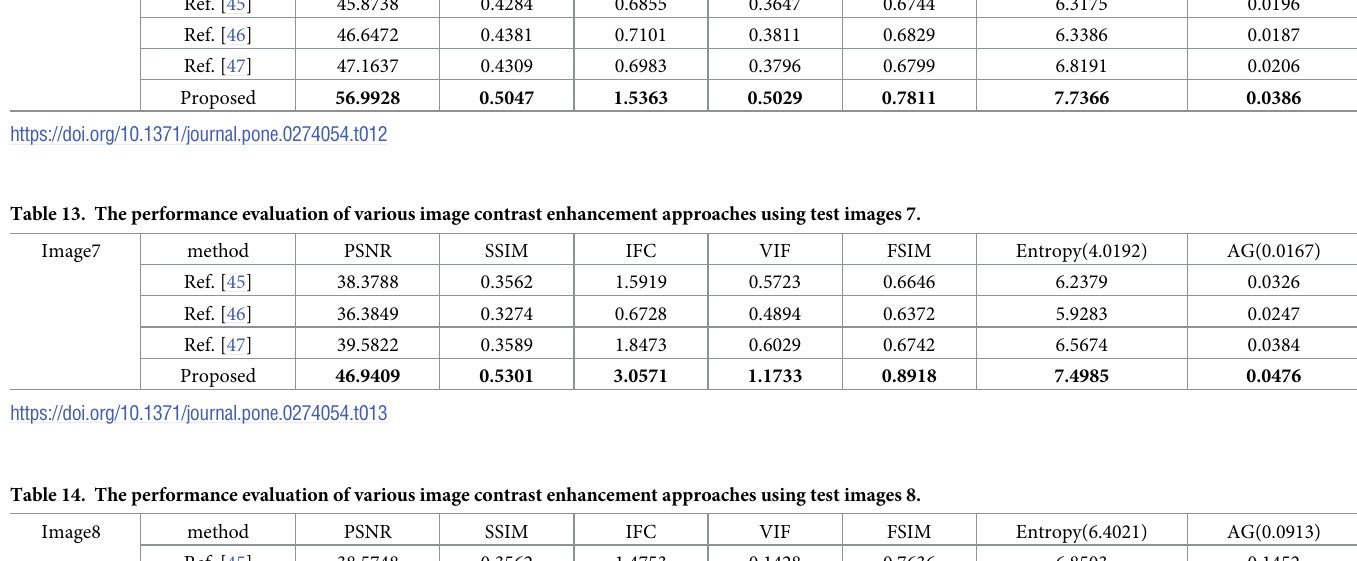
Table 12. The performance evaluation of various image contrast enhancement approaches using test images 6. Image6